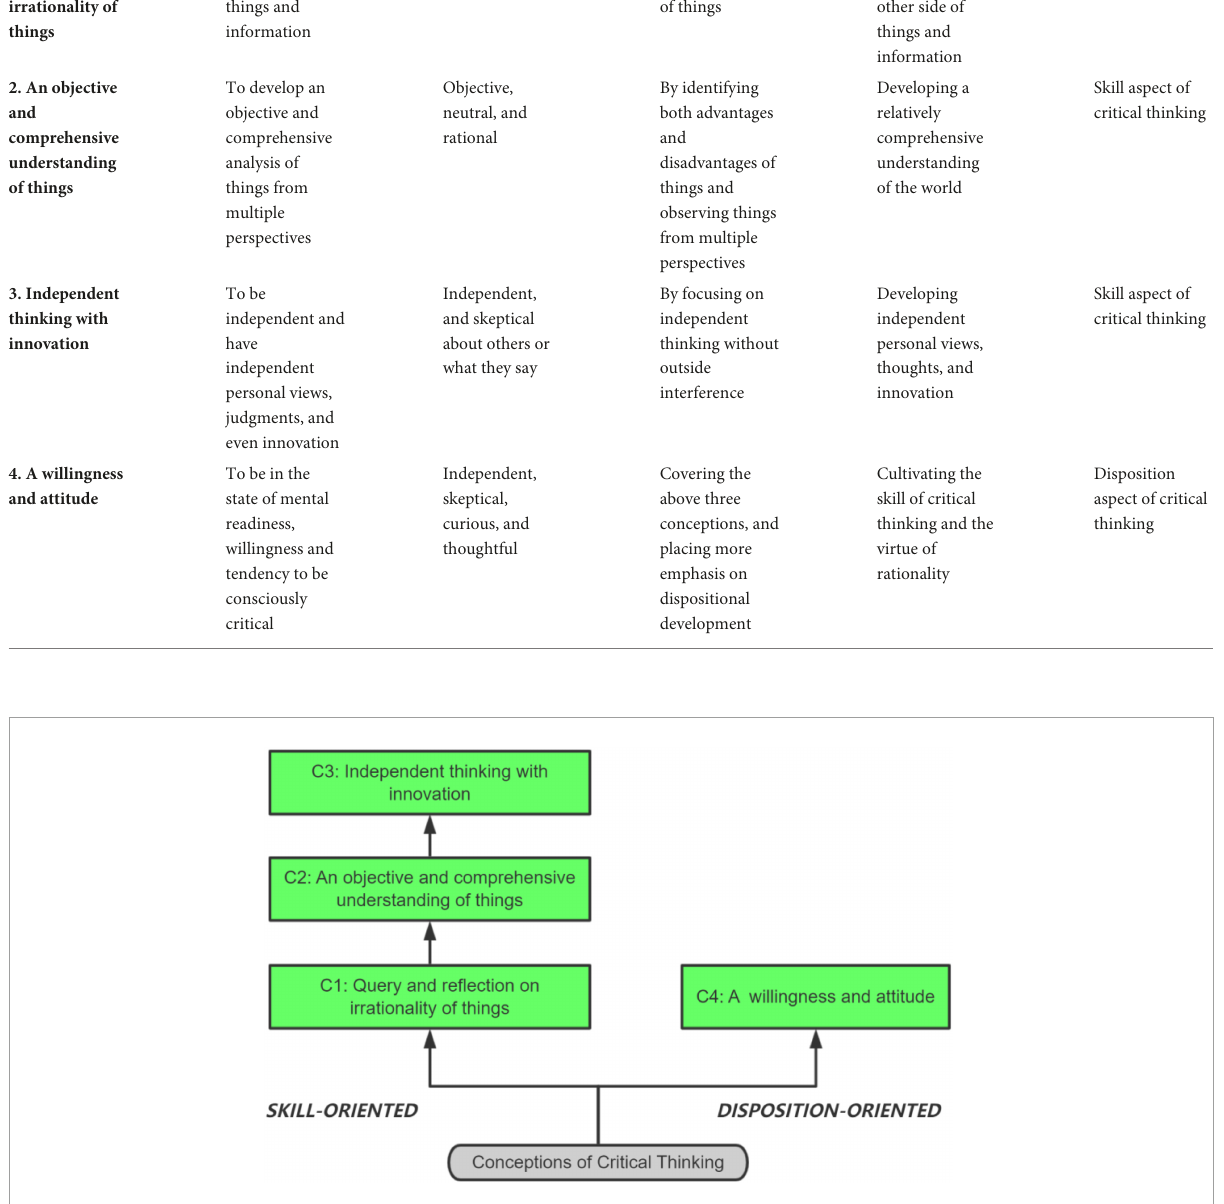
FIGURE1 The outcome